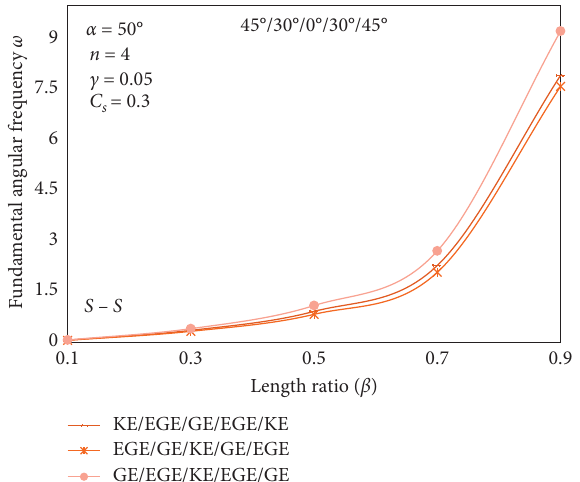
Figure 10: Influence of length ratio on the fundamental angular frequency of five-layered conical shells with different material combinations.